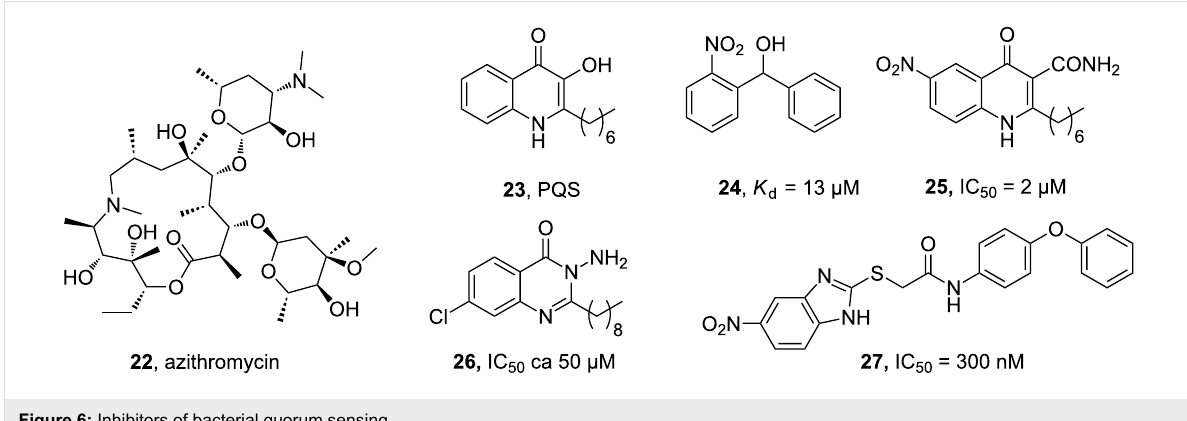
Figure 6: Inhibitors of bacterial quorum